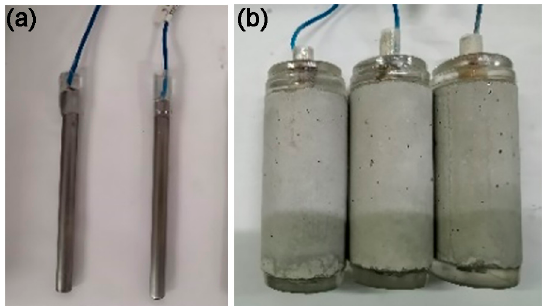
Figure 1. ( a ) the reinforcing bar welded with copper wire; ( b ) the LDHs incorporated mortar specimens with embedded reinforcing bar.